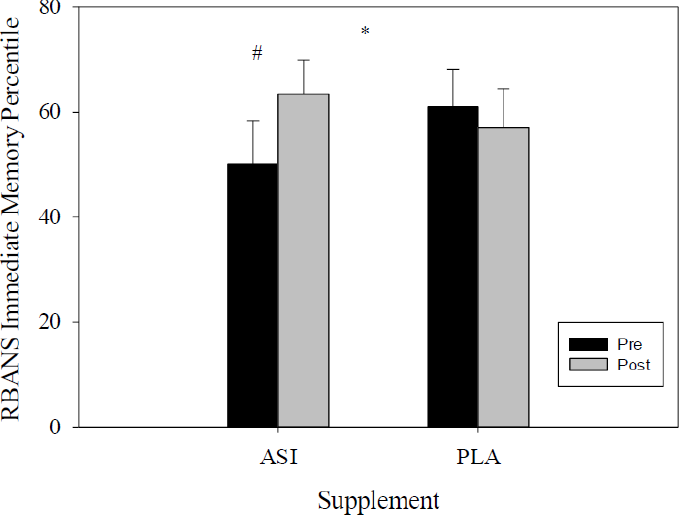
Figure 3. Immediate memory percentile score. * indicates differences between supplement; # indi- cates differences within-trial.